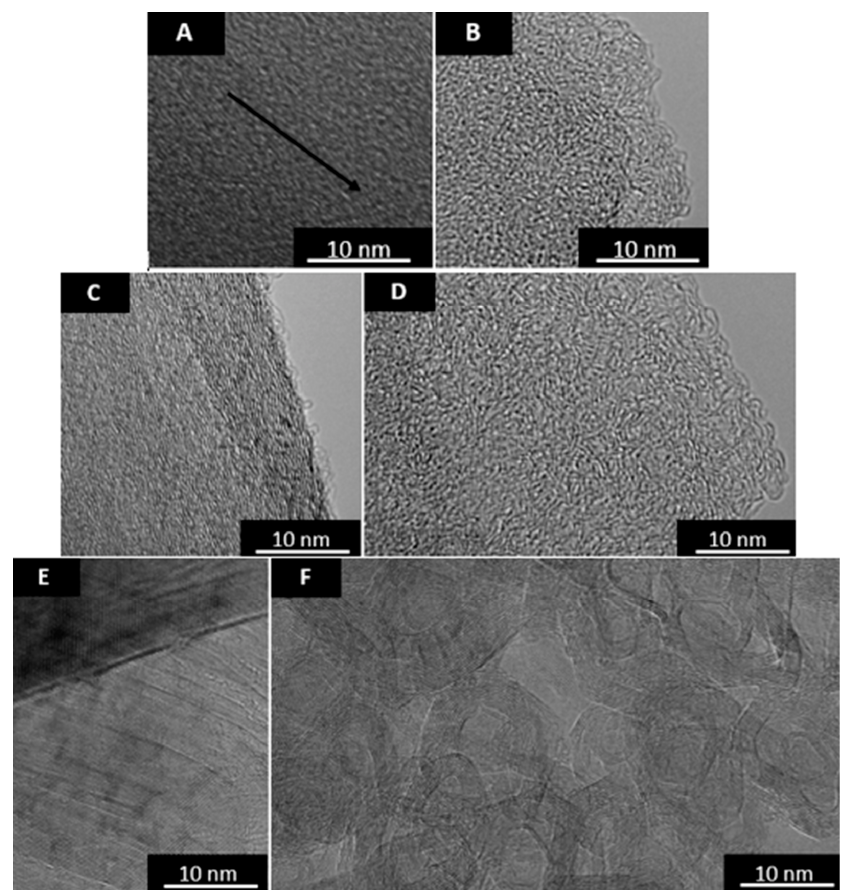
Figure 3. TEM micrographs of as prepared ( A ) anthracene coke ( B ) sucrose char. TEM micrographs of ( C ) anthracene coke ( D ) sucrose char-HTT 1200 °C for 1 h. TEM micrographs of ( E ) anthracene coke ( F ) sucrose char-HTT 2600 °C for 1 h.